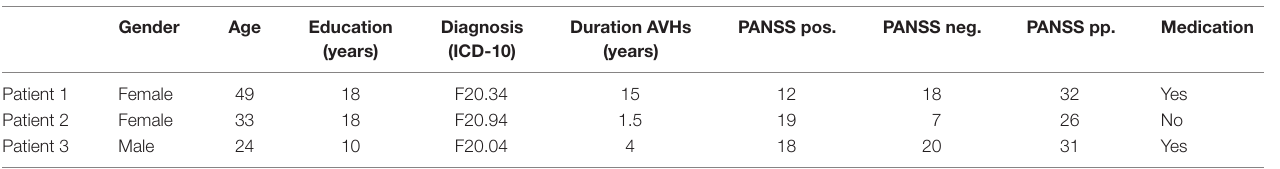
taBLe 1 | Demographic and psychopathological information of the